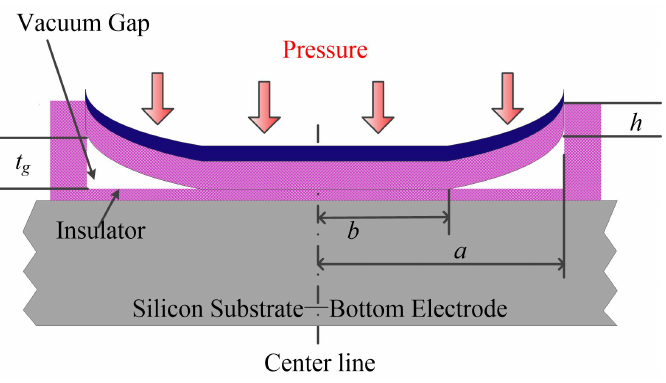
Figure 2. The cross-sectional view of a collapse CMUT with full top electrode. b is the collapse radius. Table 1. Advantages and disadvantages of collapse mode